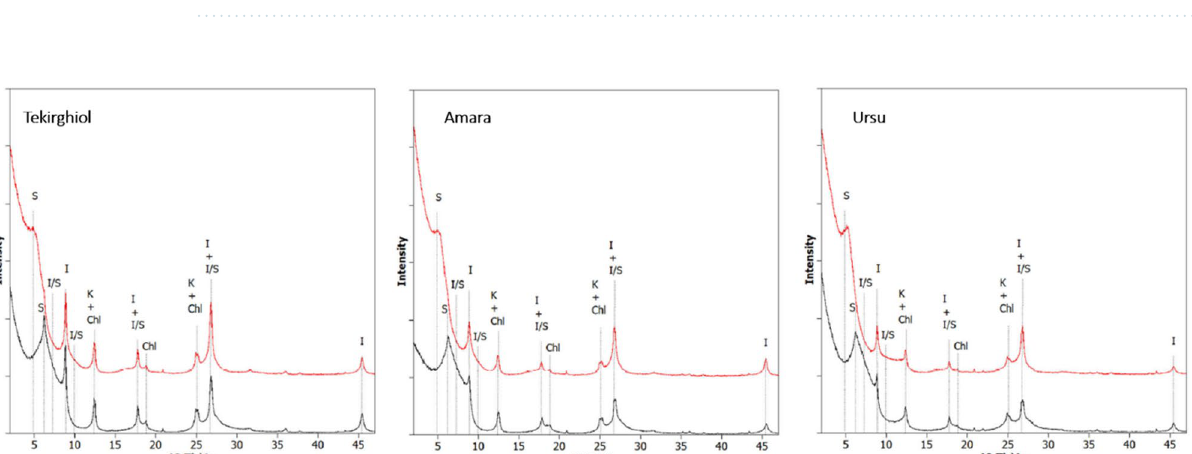
Table 2. Quantitative mineralogical clay composition of the fraction < 2 μm of the samples (in weight percentages).